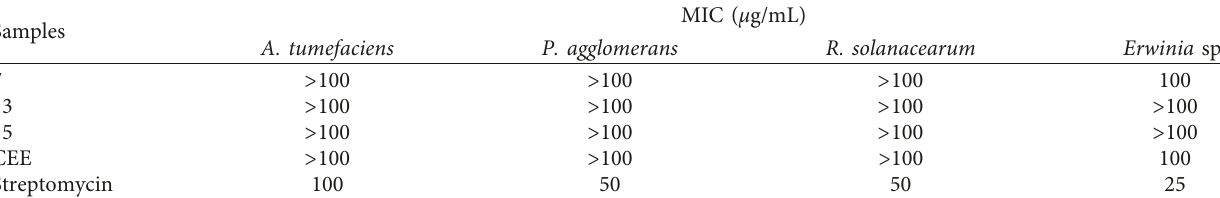
Table 5: Antibacterial activity data of compounds 7, 13, and 15 and